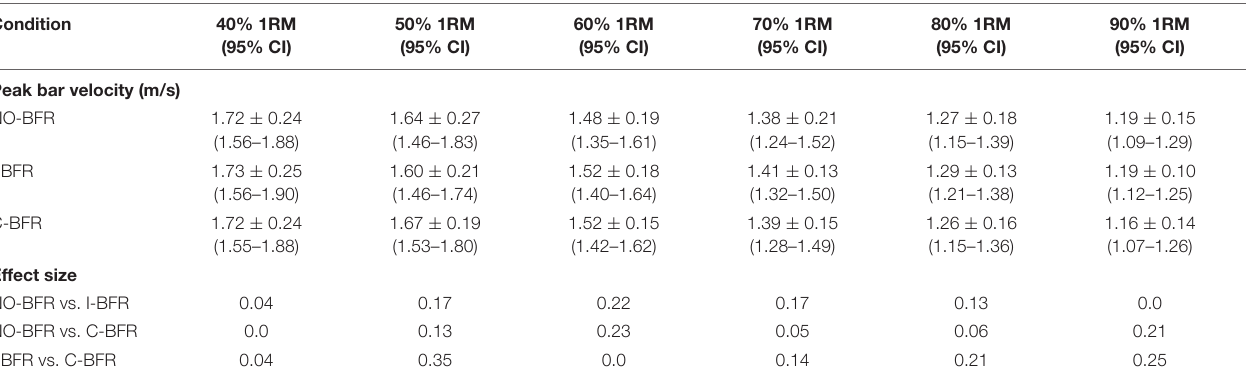
TABLE 2 | Peak bar velocity during the bench press exercise for six different